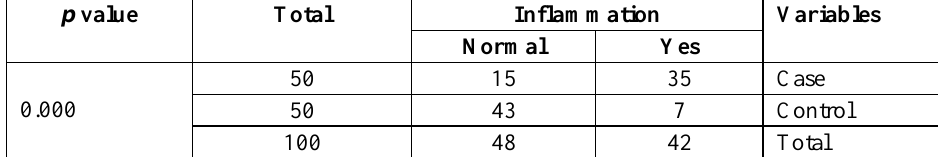
Table 2. Frequency of inflammation among studied groups.